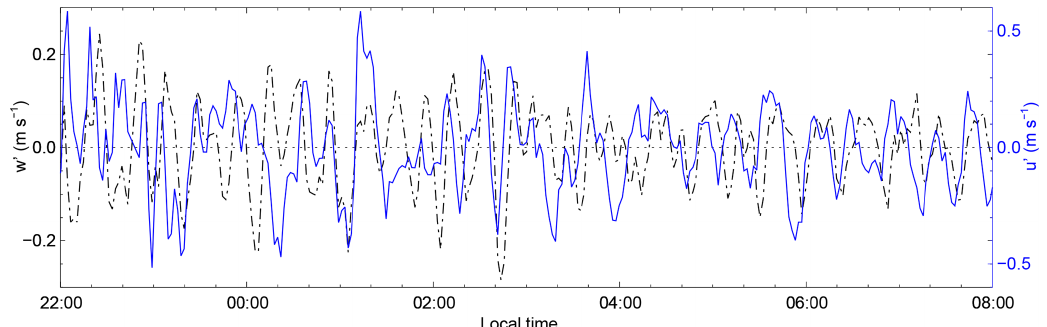
Figure 4. Perturbations of vertical wind w (cid:48) (black dash-dotted line, left axis) and zonal wind u (cid:48) (blue solid line, right axis) obtained between 600 and 1000m altitude from 22:00 on 4 September to 08:00 on 5 September 2018.